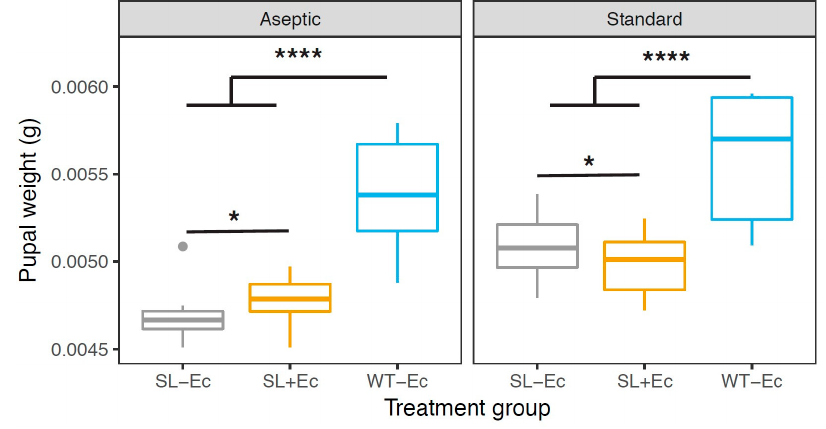
Figure 3. The e ff ect of rearing regime, genotype, and inoculation with gut bacteria ( E. cloacae ) on the distribution of male pupal weights. ‘SL − Ec’ represents self-limiting transgenic Plutella xylostella pupae without E. cloacae , ‘SL + Ec’ represents self-limiting transgenic P. xylostella pupae with E. cloacae , and ‘WT − Ec’ represents wild type P. xylostella pupae without E. cloacae . For aseptic conditions, male pupae were weighed from 35 Petri dishes in each SL treatment group (700 pupae in all) and 12 Petri dishes in the WT − Ec treatment group (110 pupae). Standard rearing conditions used 11–12 replicate tubs (674 SL pupae and 85 WT pupae). Asterisks indicate treatment contrasts showing significant di ff erences between treatment groups (* p < 0.05, **** p < 0.0001).